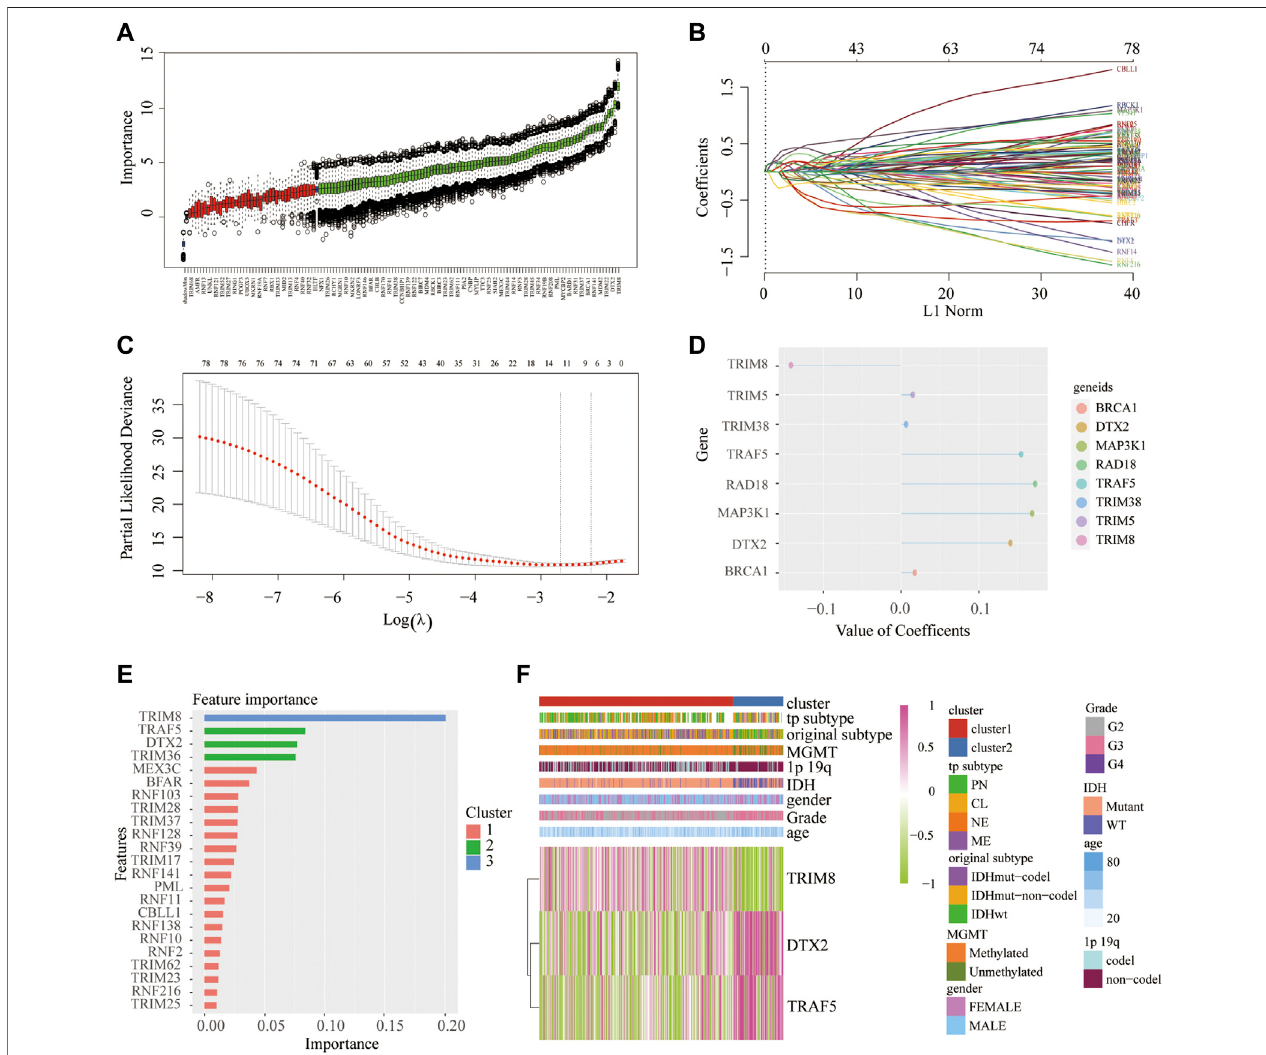
FIGURE 8 | Identi fi cation of main contributors of the cluster model from RNF family members. Identify main contributors of the cluster model from RNF family members by Boruta algorithm (A) , LASSO regression analysis (B – D) , and Xgboost algorithm (E) . Heatmap shows the expression of three main contributors in two clusters (F)